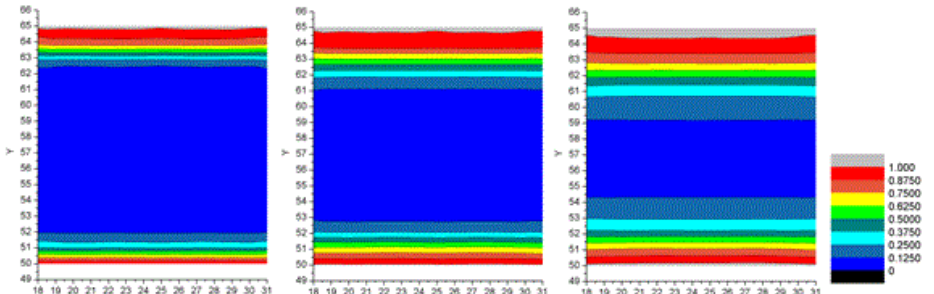
Figure 17 – Isoprobability of failure curves for slab region. Probability of failure values for 25 years, 50 years and 75 years. Dimensions in